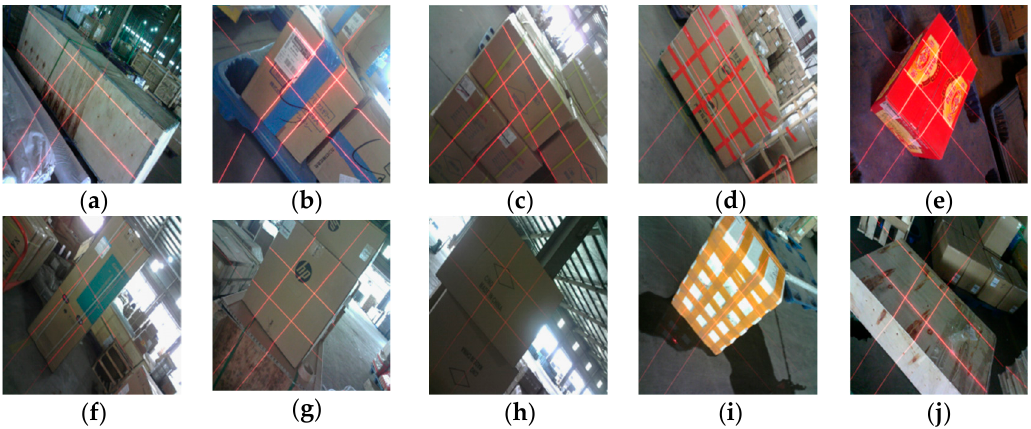
Figure 3. Images that are captured by our device in the distribution center; ( a )–( j ) show the different images captured by our system.